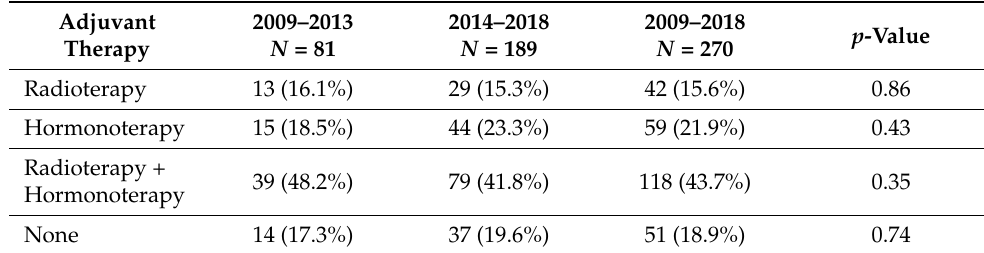
Table 7. Adjuvant therapy offered to our